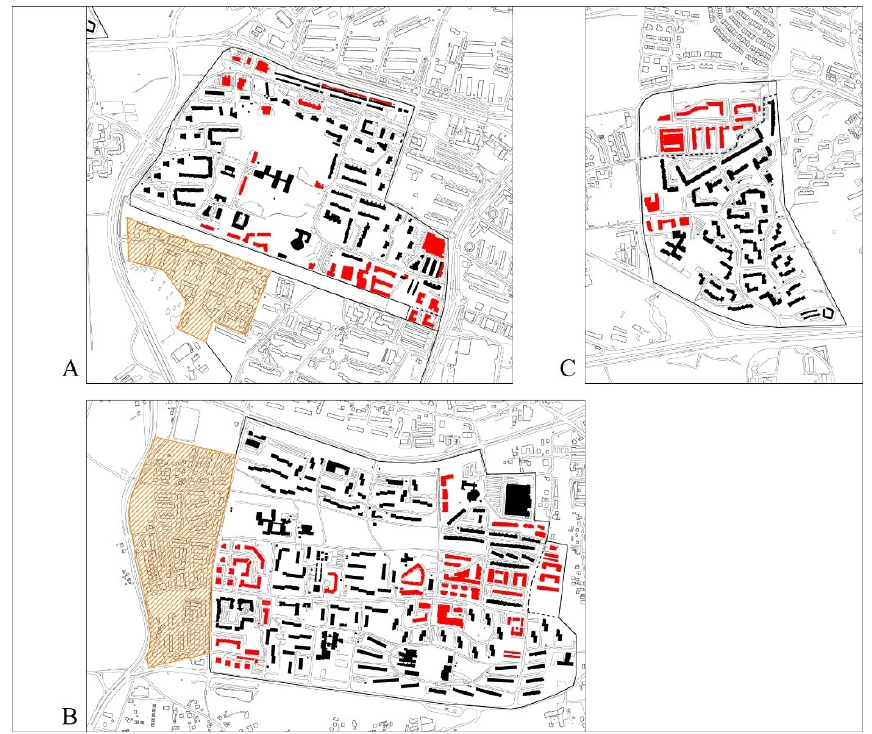
Figure 7. Cracow large-panel housing estates with the highest intensity of densification: ( A )—the Dywizjonu 303 housing estate; ( B )—the Kurdwan ó w housing estate; ( C )—the O´swiecenia housing estate. Color legend: black—developments from before 1995; red—densification—developments from after 1995; orange—other multi-family housing areas next to the large-panel housing